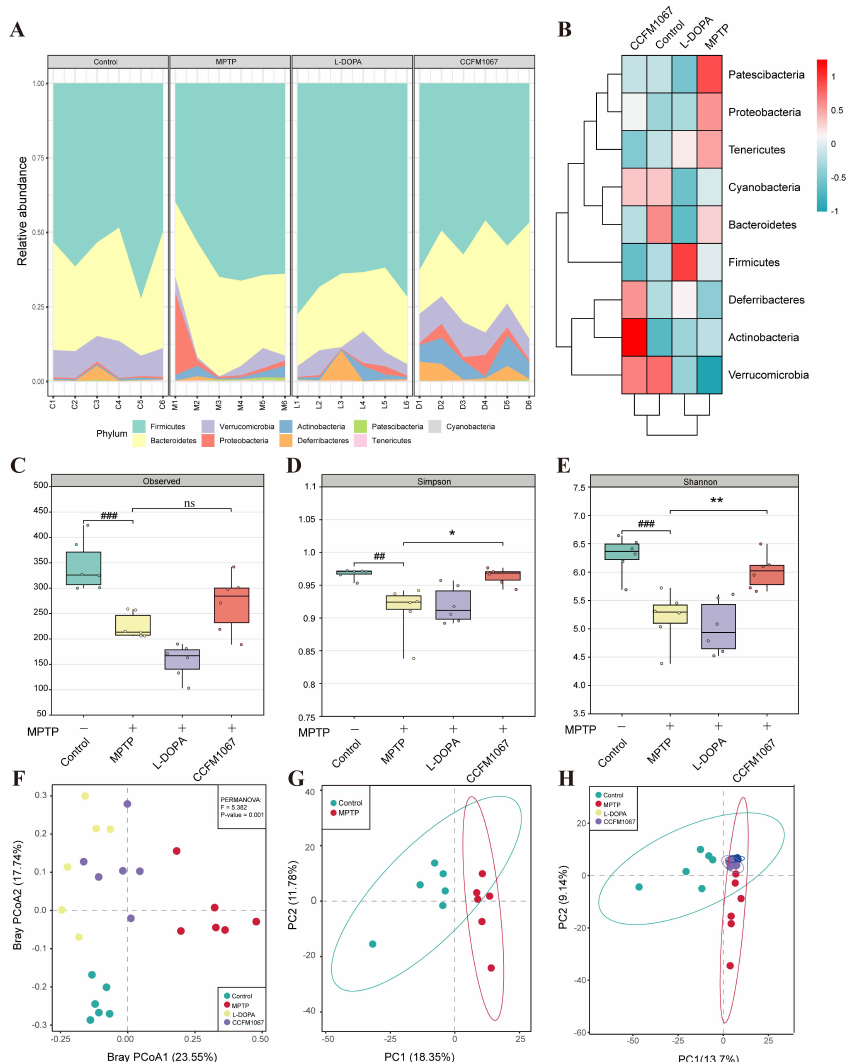
Figure 4. Phylum − level changes and gut microbiota diversity analysis among the control, MPTP, L − DOPA, and B. breve CCFM1067 groups ( A ) Stacked bar plots representing the relative abundance of phyla in individual samples from the four different groups. ( B ) Heat map of the relative abundance of nine bacterial phyla. ( C – E ) α − diversity analysis: Observed, Shannon, and Simpson indexes. ( F ) PCoA of β − diversity. The Bray–Curtis matrix, analyzed with PERMANOVA, was used to evaluate the differences between groups. The axes are labeled with the contribution vectors (PCoA1 and PCoA2) of the main components, and mouse samples are color-coded to distinguish across groups. ( G ) Principal component analysis (PCA) of β − diversity between the control and MPTP − treated groups. ( H ) PCA of β− diversity among the four groups. Data are means with SEM; ## p < 0.01, ### p < 0.001 compared with the Control group; * p < 0.05, ** p < 0.01 vs. MPTP group, “ns” means there was no noticeable difference between the groups.